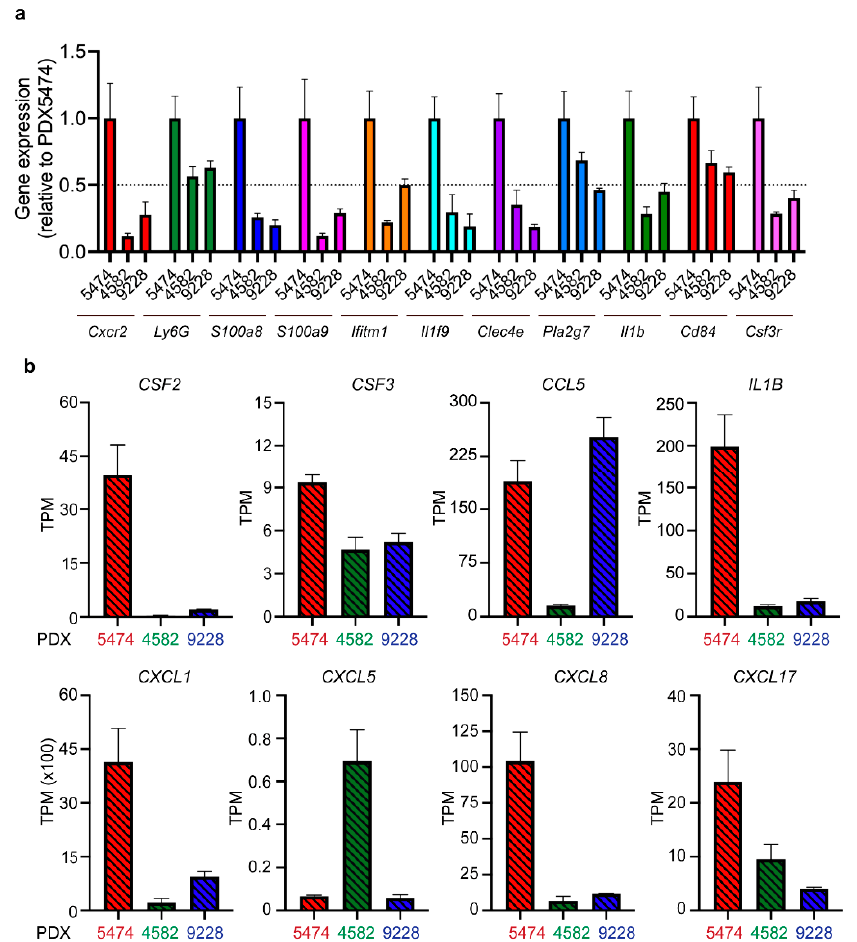
Figure 3. RNA sequencing analysis reveals differences in the expression of MDSC-associated genes